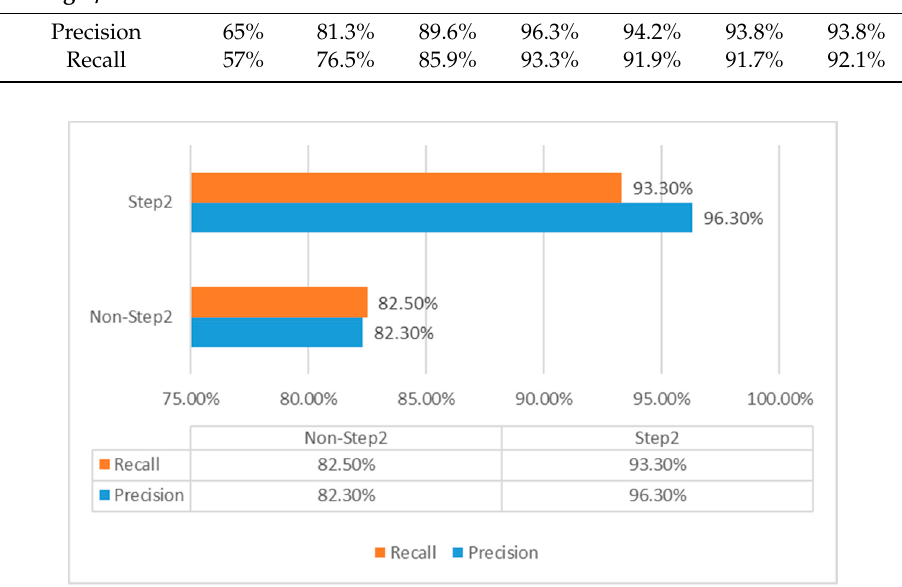
Figure 8. The Ablation experiment. By setting the threshold of the aspect ratio of the contour for interference contour filtering, the Precision rate can be increased by 14% and the Recall rate by 10.8%.